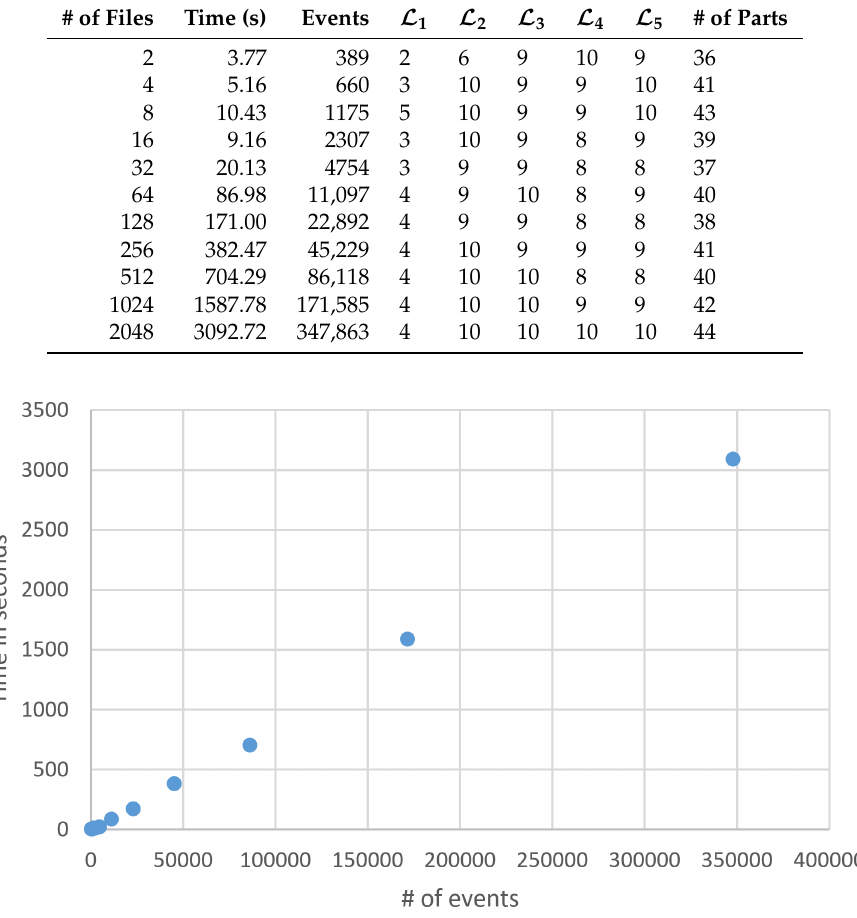
Figure 18. The graph shows the time needed to train a model (in seconds) in relation to the number of input events. The dependency is